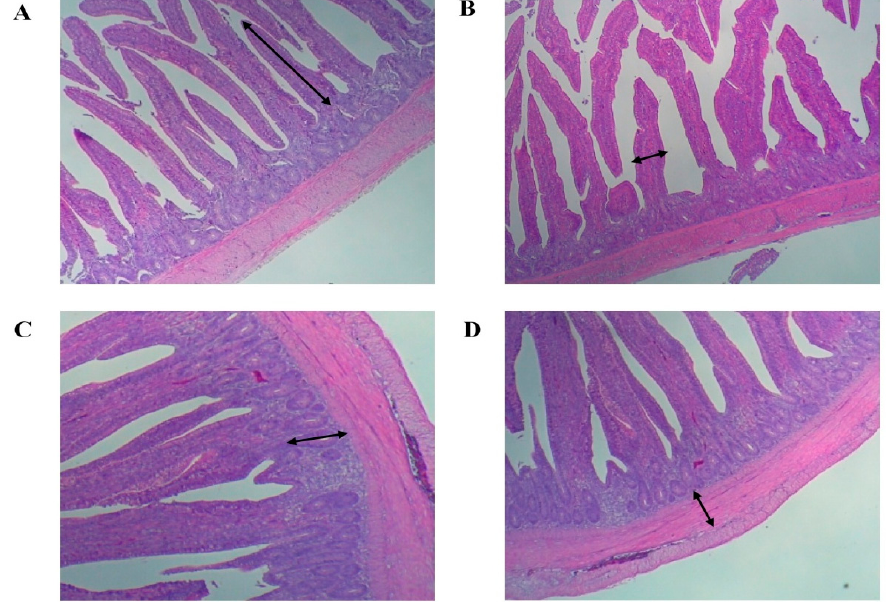
Figure 1. Intestine morphometric measurements ( A ). Villus height, ( B ). Villus width, ( C ). Crypt depth, ( D ). Mucosal depth. Bar: 100 μ m.